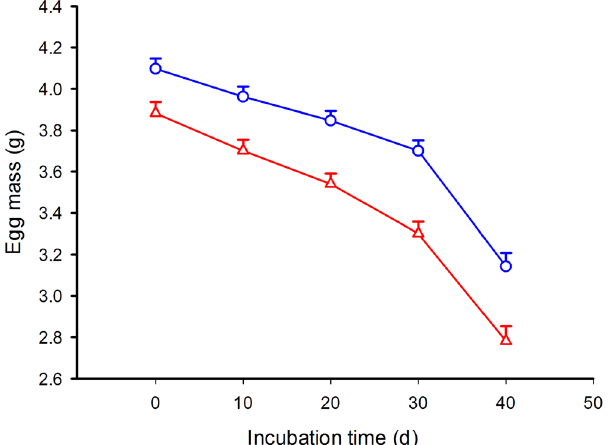
Figure 1. Egg mass trajectories were recorded every 10 days from laying to hatching in 30 water snake eggs from which 7.2% of yolk had been removed shortly after oviposition (red triangles) and 29 control eggs (blue circles). A repeated measure two-factor Anova with treatment and clutch of origin as factors and the successive egg masses as the repeated measure yielded: interaction term: F 5.34, 53.38 = 1.43, P = 0.22; effect of treatment over time F 1.78, 53.38 = 1.99, P = 0.15; effect of treatment F 1, 30 = 24.05, P < 0.0001. As the assumption for sphericity was violated (W = 0.051, χ